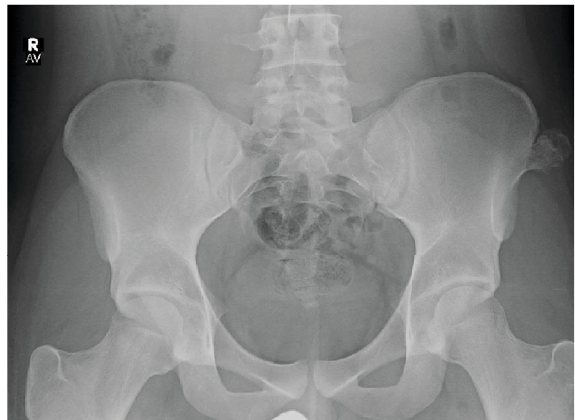
Figure 1: Preoperative anterosuperior pelvis plain- fi lm